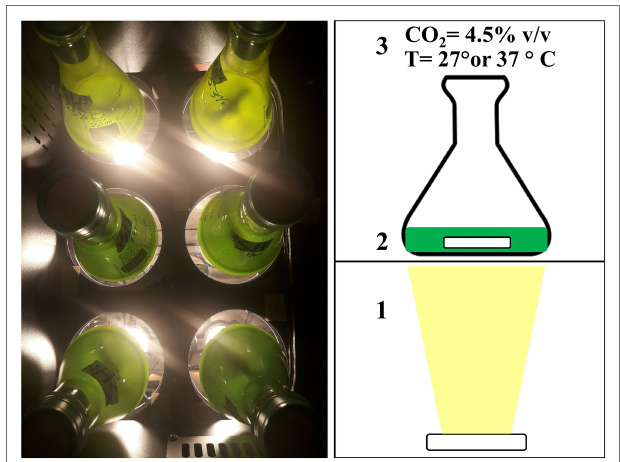
FIGURE 1 | Picture (left) and schematic view of the incubator used during the autotrophic experiment. Light was provided from below using a LED (1), flasks were stirred at 100 rpm with a magnetic rod (2), and the head space of the incubator was enriched with 4.5% v/v carbon dioxide (CO 2 ; 3). Temperature of the incubator was maintained constant, either at 27 ° C or at 37 ° C, depending on the experiment (3).